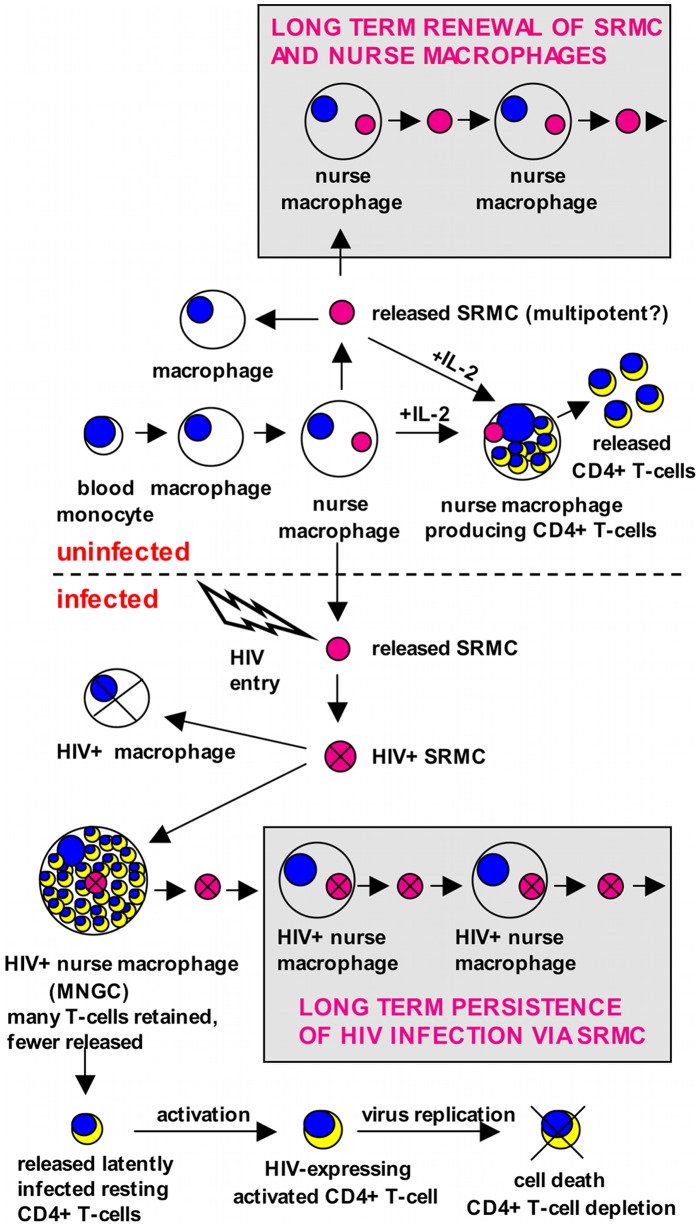
A model for nurse macrophage capabilities and role in HIV-1 pathogenesis.
In vitro, we observed that human blood monocytes differentiate into macrophages, and that a portion of these can further develop into what we term “nurse macrophages.” These nurse cells can generate within themselves, CD4+ T-lymphocytes, as well as a previously unknown small monocytoid cell (SRMC). The SRMC, itself, can develop into a nurse macrophage with the ability to give rise to another SRMC. The NM/SRMC cycle, then, represents a form of self-renewal. When cultures of human macrophages are exposed to HIV-1, the SRMC become productively infected, but virus expression does not kill them. Rather, they can differentiate into macrophages, including nurse macrophages, in the presence of virus expression. Thus, a NM/SRMC cycle is established that is characterized by ongoing HIV-1 expression. In the absence of HIV-1 infection, nurse macrophages release resting CD4+ T-cells. The development and release of these lymphocytes is enhanced by treatment with IL-2. When productively infected with HIV-1, the nurse macrophage retains, rather than releases the T-lymphocytes and as a consequence, it takes on the appearance of a multinucleated giant cell. We propose that these events may recapitulate events that occur in vivo and if so, this model offers explanations for HIV-1 persistence and latency.